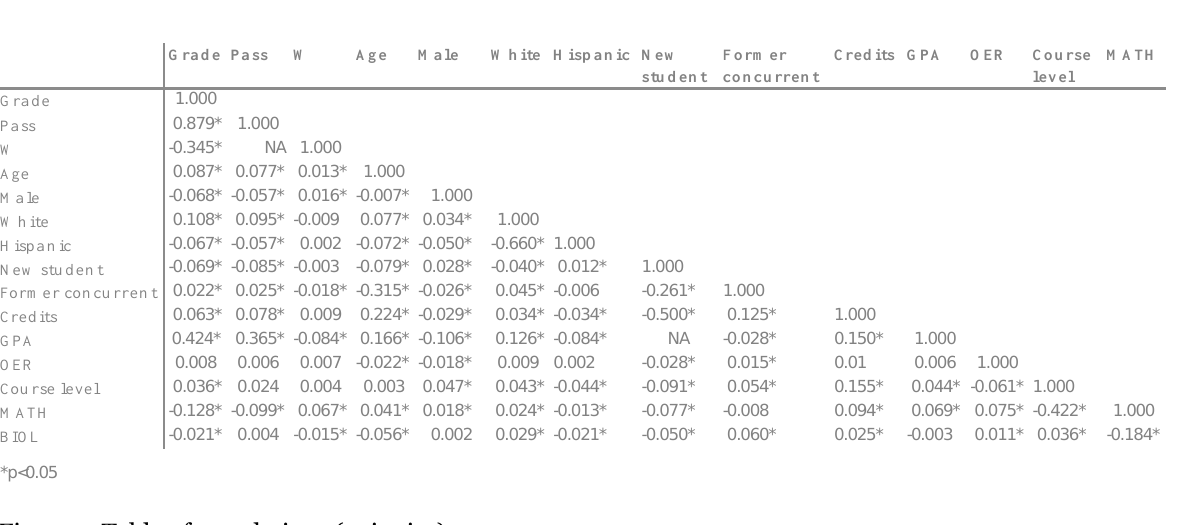
Figure 7. Table of correlations (pairwise).